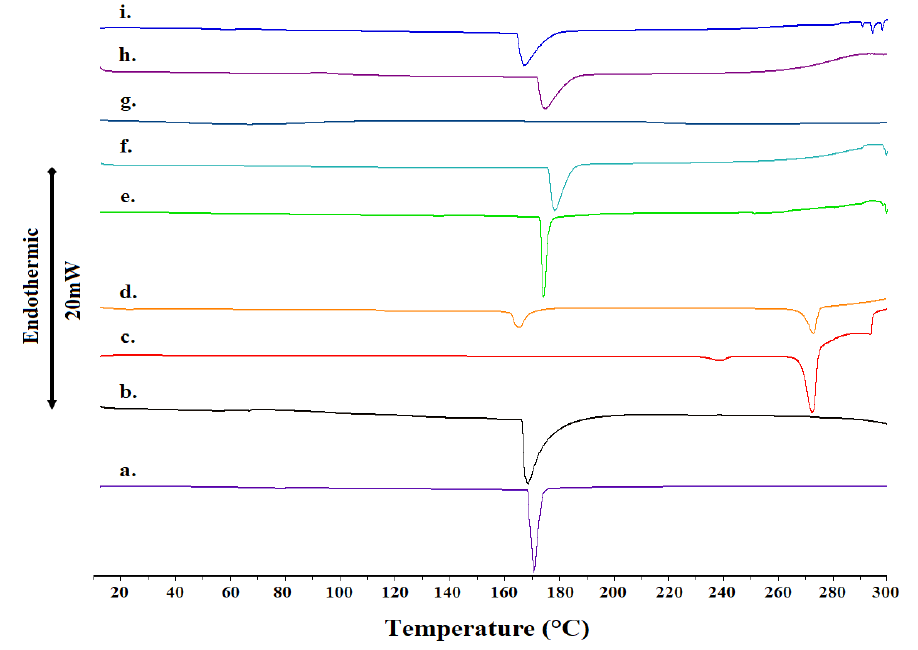
Figure 2. DSC scans of (a.) 2-HP- β -CD raw material; (b.) 2-HP- β -CD lyophilized; (c.) losartan raw material; (d.) losartan lyophilized; (e.) mixture of 2-HP- β -CD and losartan raw materials; (f.) mixture of lyophilized 2-HP- β -CD and raw material losartan; (g.) mixture of raw material 2-HP- β -CD and lyophilized losartan; (h.) mixture of lyophilized 2-HP- β -CD and lyophilized losartan; and (i.) lyophilized complex of 2-HP- β -CD and losartan. The bar represents a heat flow amount of 20